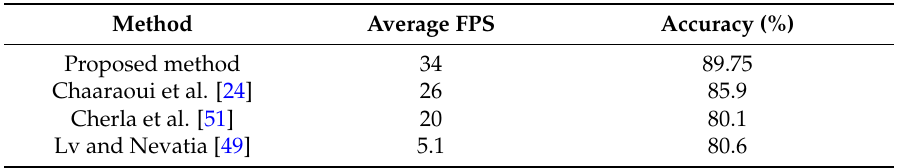
Table 3. Comparison of average testing speed on IXMAS